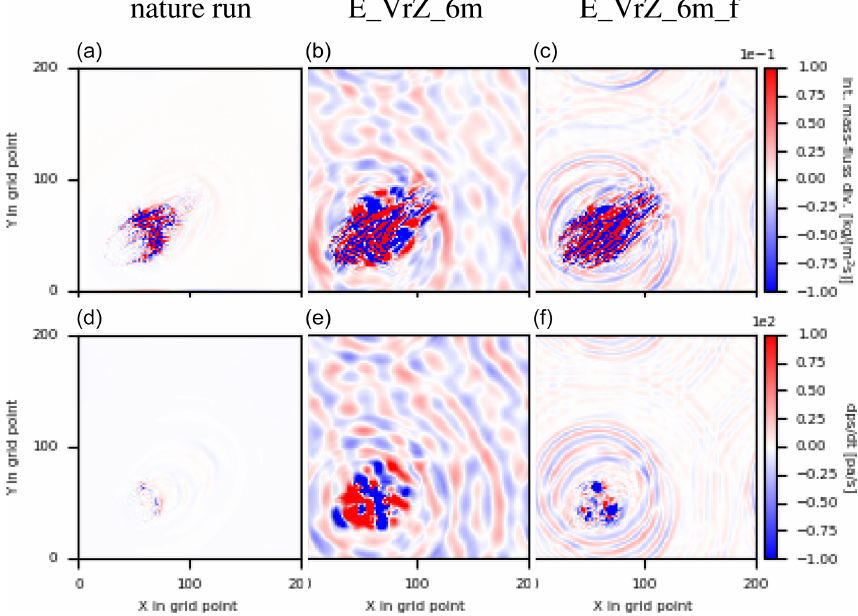
Figure 3. The upper row is for the integrated mass-flux divergence of the nature run (a, d) as well as analyses of E_VrZ_6m (b, e) and E_VrZ_6m_f (c, f) at 15:00UTC; the second row is for the surface pressure tendency.